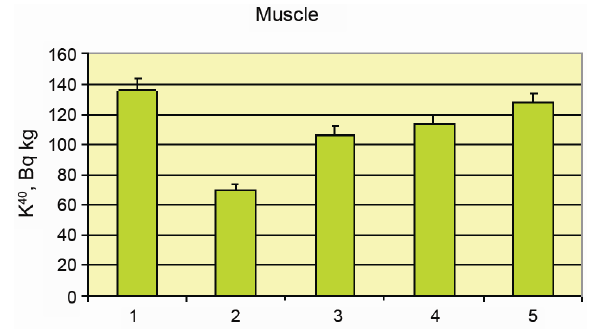
Fig. 7. Specific activities of